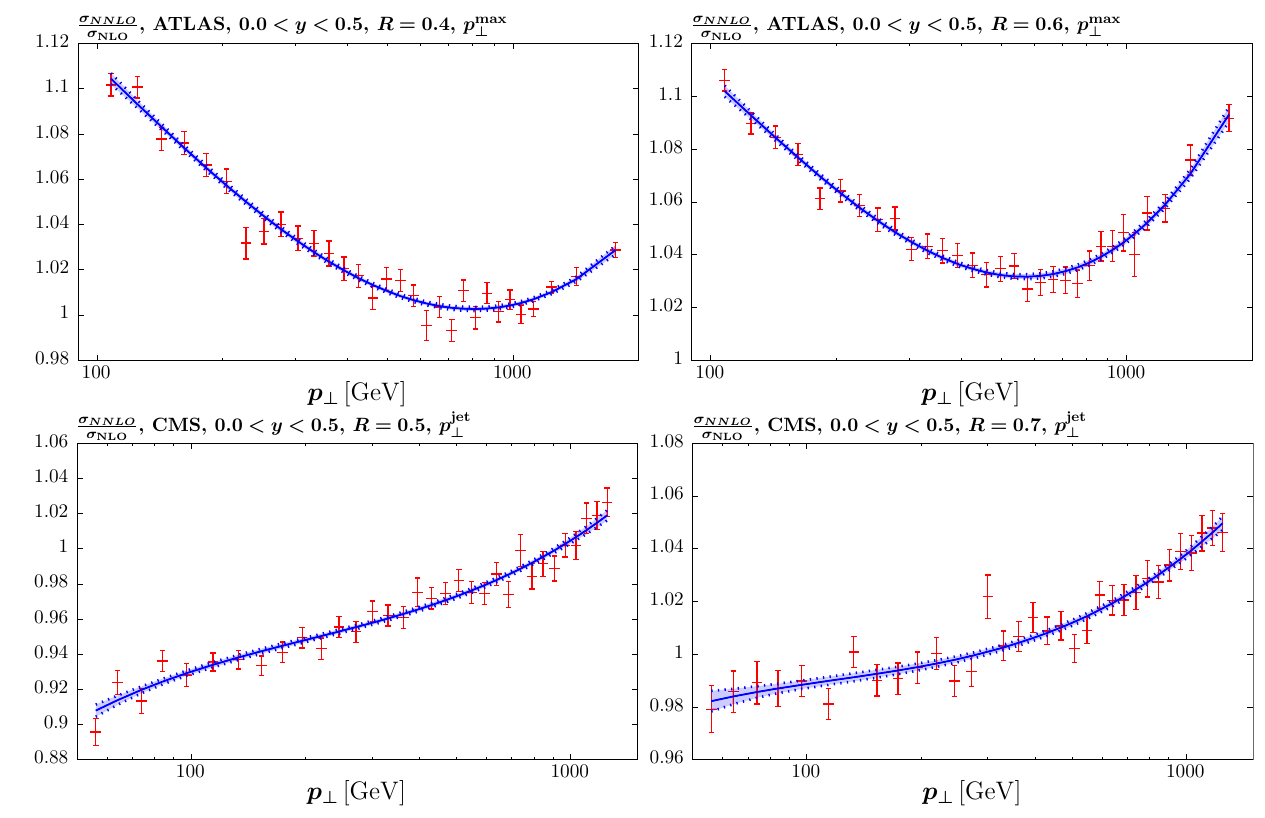
Fig. 1 ThecalculatedNNLOtoNLO K -factors[22],includingtheMC statistical errors, for representative ATLAS and CMS 7 TeV jet kine- matics. Also shown is the four-parameter fit to the K -factors described in the text. The uncertainty band is shown for illustration by summing in quadrature the 68% C.L. fit uncertainties in each bin, i.e. omitting